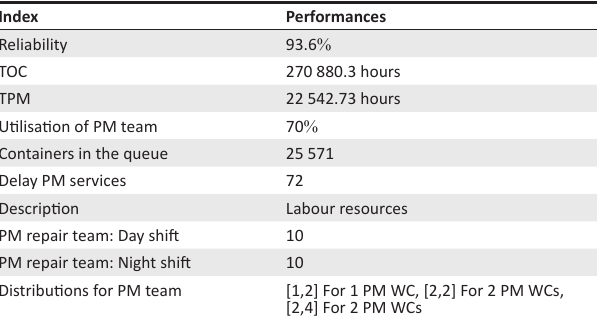
TABLE 8: Scenarios for preventative maintenance service changes: Changes caused by adding two preventative maintenance technicians.